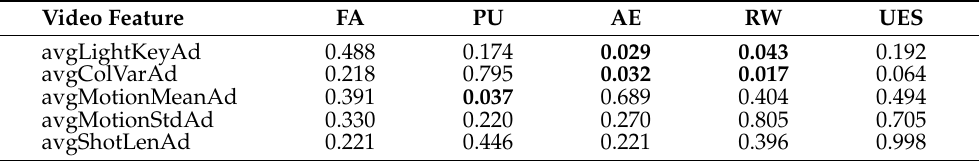
Table 4. Reported p -values of Kruskal–Wallis test with randomized effects, where the independent variables are the video features, and the dependent variables are the individual dimensions of the UES-SF scale. Video Feature FA PU AE